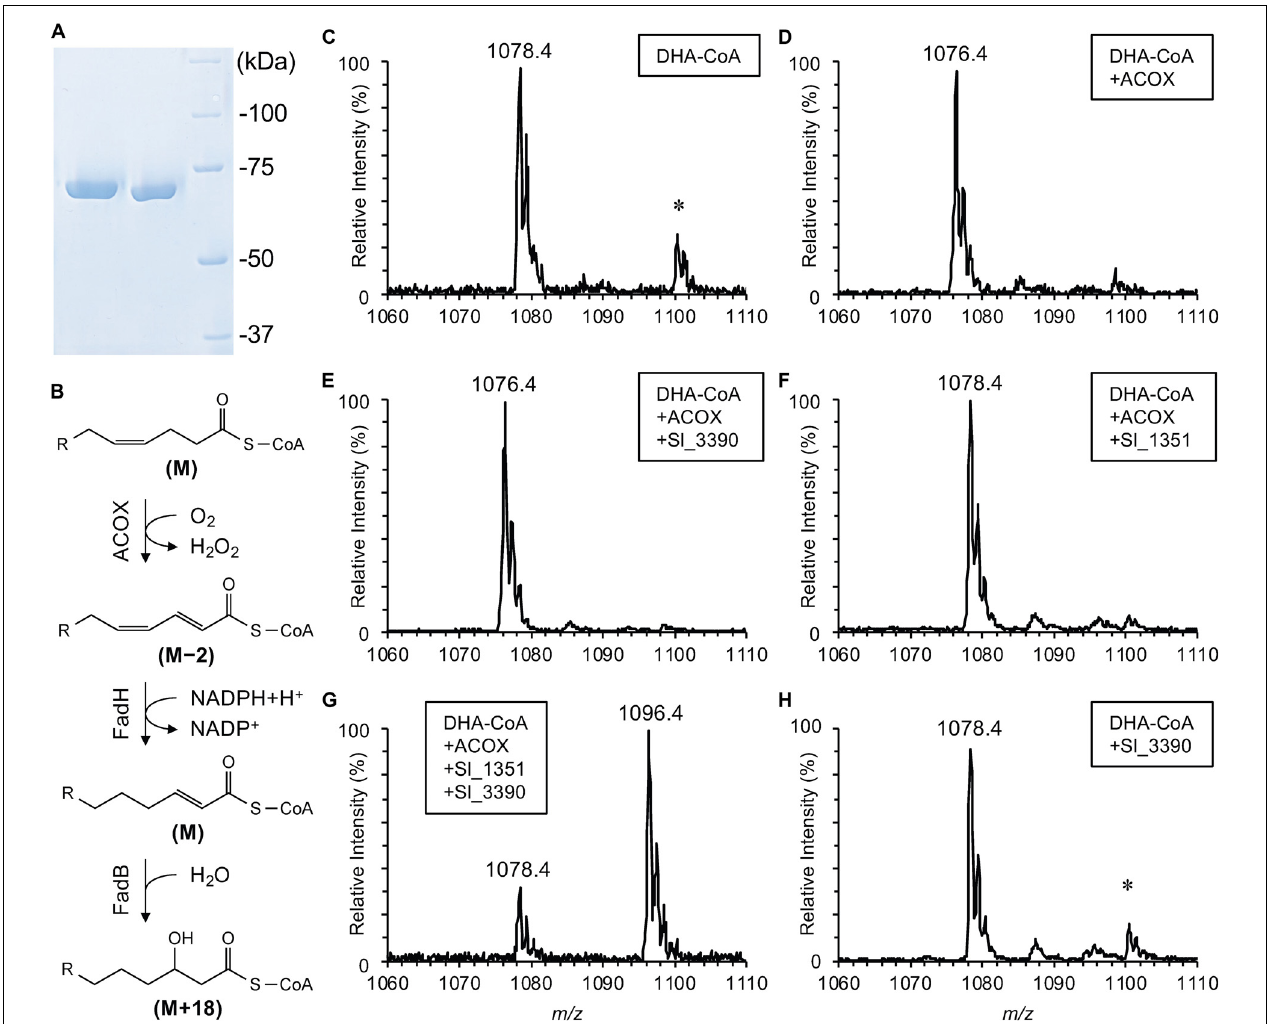
FIGURE 4 | In vitro assay for recombinant Sl_1351. SDS-PAGE analysis of the purified recombinant proteins ( A ; lane 1, Sl_3390; lane 2, Sl_1351; lane 3, protein standards), a reaction scheme of the β -oxidation ( B ; relative mass changes are indicated in the brackets), and ESI-MS analyses of DHA-CoA (C) and its derivatives after incubation with ACOX alone (D) , ACOX and Sl_3390 (E) , ACOX and Sl_1351 (F) , ACOX, Sl_1351 and Sl_3390 (G) , and Sl_3390 alone (H) . The m/z values are provided for [M + H] + ions. The asterisk indicates [M + Na] + ions with m/z larger than the corresponding [M + H] + ions by